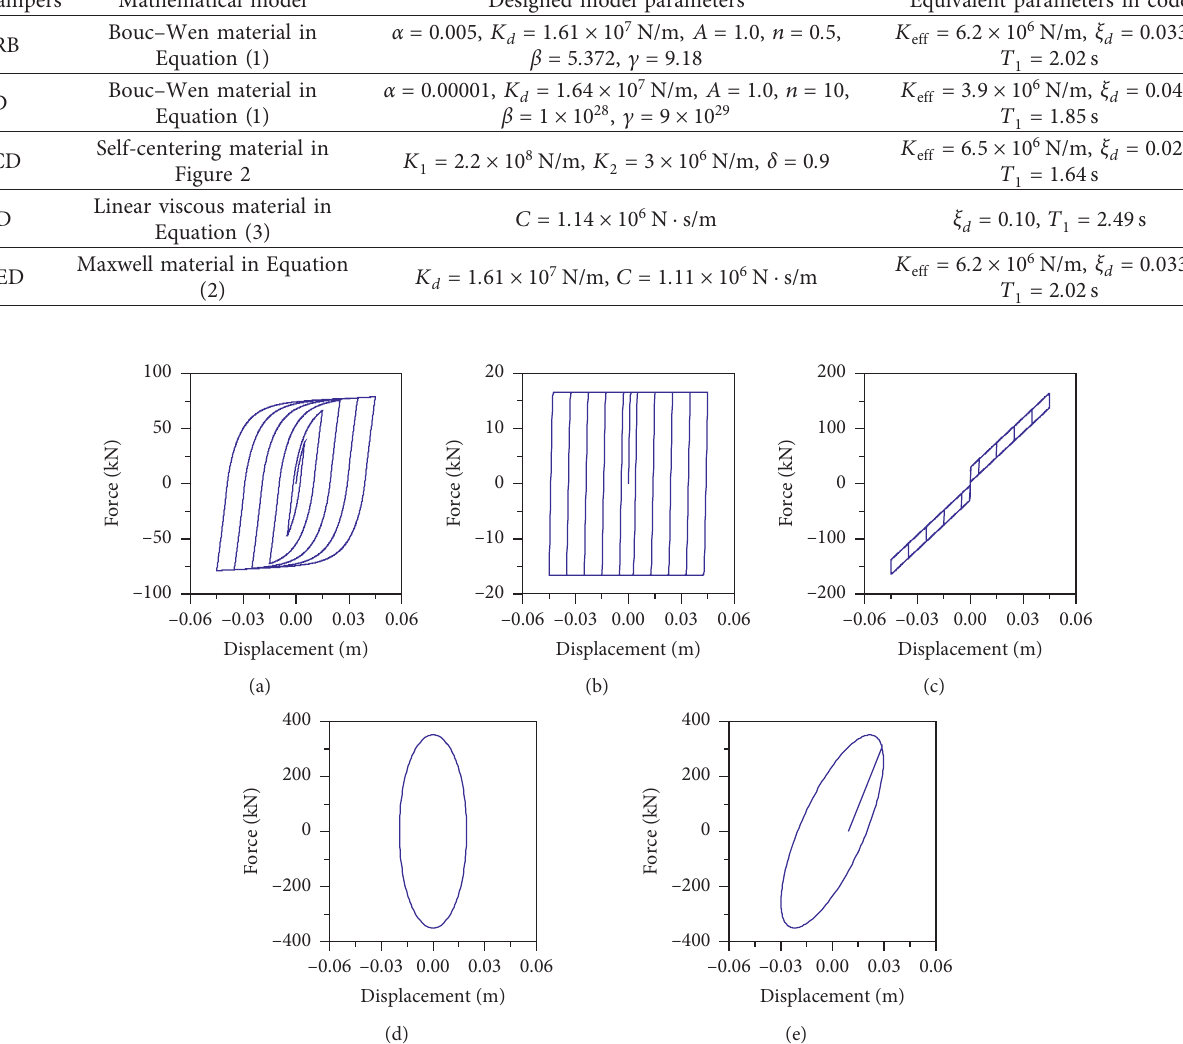
Table 2: The designed model parameters of five typical dampers.